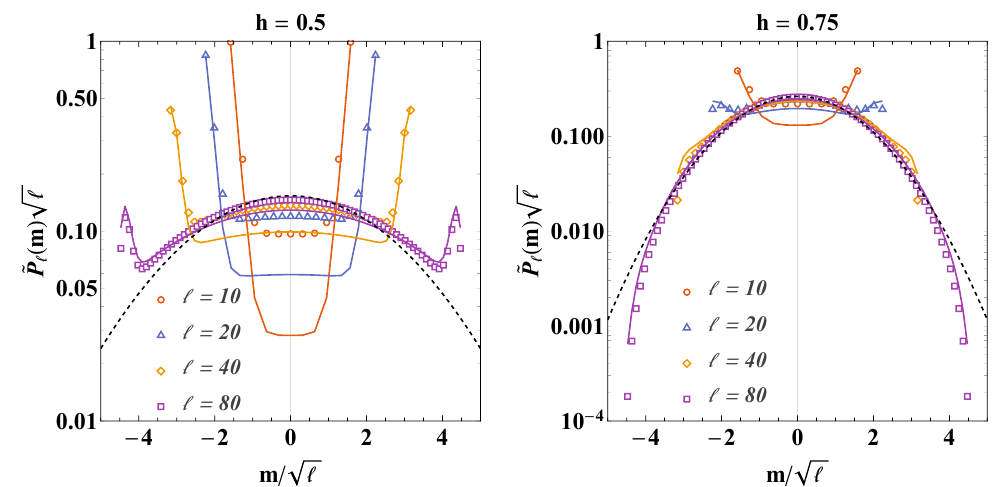
Figure 4: The rescaled PDF of the subsystem order parameter in the stationary state after quenching the transverse field into the ferromegnetic region (here h = 0.5 and 0.75). Symbols are the exact results obtained from the exact generating function in Eq. (48); these are compared with the large deviation scaling obtained from ] (cid:96) (full lines), where z F (cid:96) ( λ ) ∼ [ cos ( λ/ 2 ) z is defined in the Appendix D. The black- 3 3 dashed line is the Gaussian approximation F (cid:96) ( λ ) ∼ exp [ − (cid:96) ( − 5 / 4 + 2 / h 2 ) λ 2 / 2 ] valid in the thermodynamics